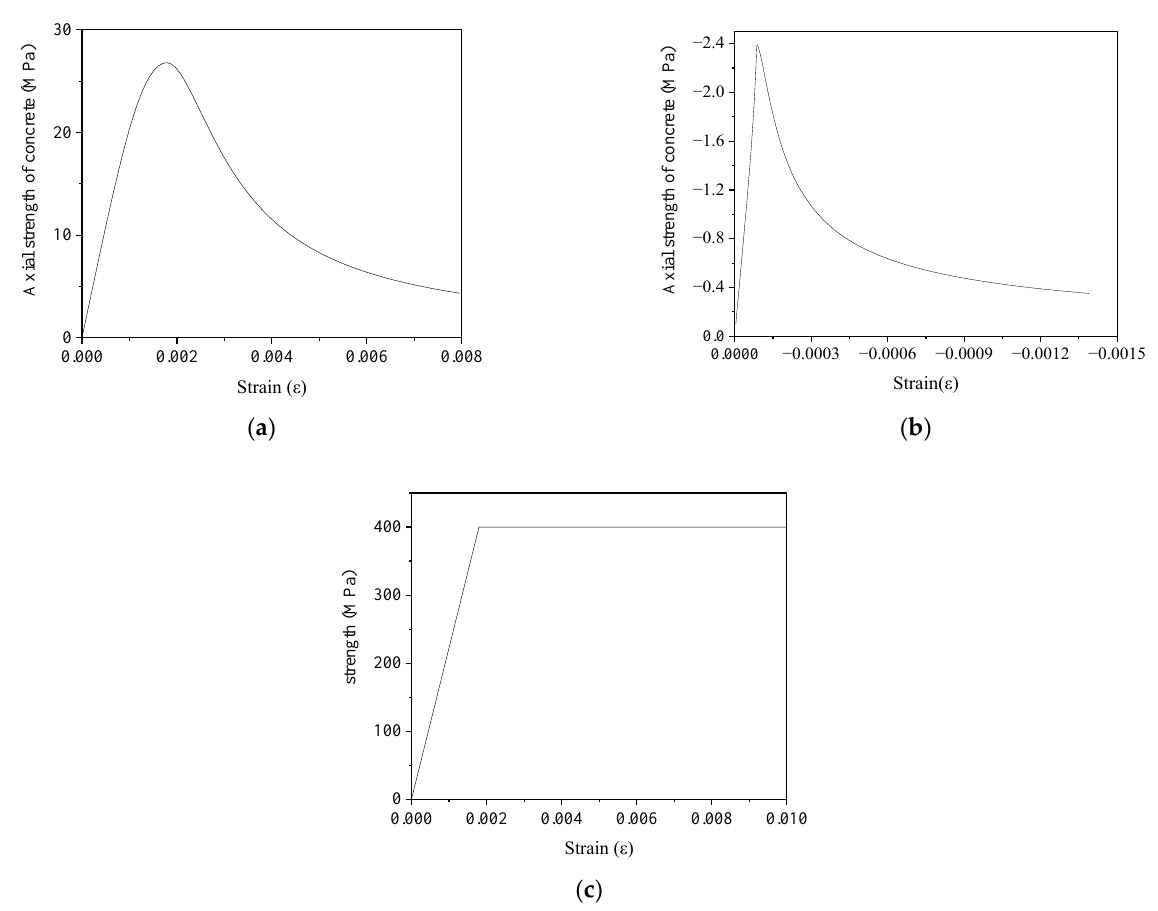
Figure 4. Constitutive Relations. ( a ) Concrete compression behavior. ( b ) Concrete tensile behavior. ( c ) Reinforcement behavior.